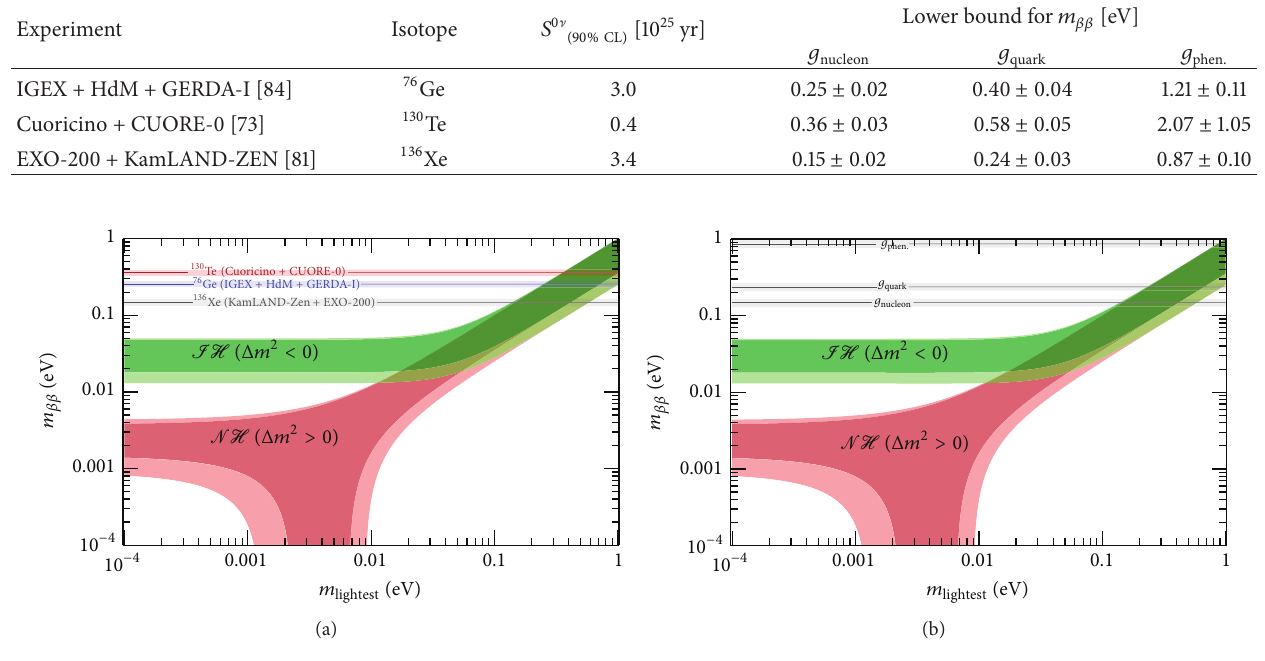
Figure 17: The colored regions show the predictions on 𝑚 𝛽𝛽 from oscillations as a function of the lightest neutrino mass with the relative 3𝜎 regions. The horizontal bands show the experimental limits with the spread due to the theoretical uncertainties on the NME [96] and PSF [81, 95]. (a) Combined experimental limits for the three isotopes: 76 Ge [84], 130 Te [73], and 136 Xe. The case 𝑔 𝐴 = 𝑔 experimental limit on 136 Xe for the three different values for 𝑔 𝐴 , according to